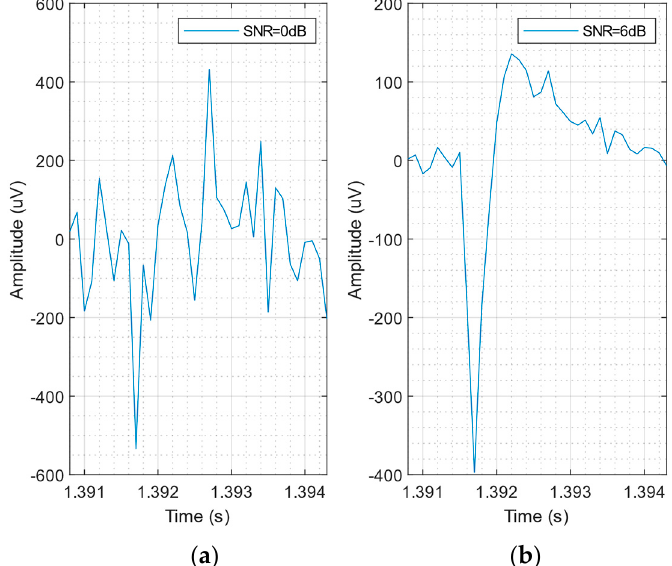
Figure 2. Signal detected by pixel #1 for a neuron positioned on the west side of the sensor at different SNR levels, adding white noise on a noiseless synthetic recording. ( a ) SNR = 0 dB and ( b ) SNR = 6 dB.